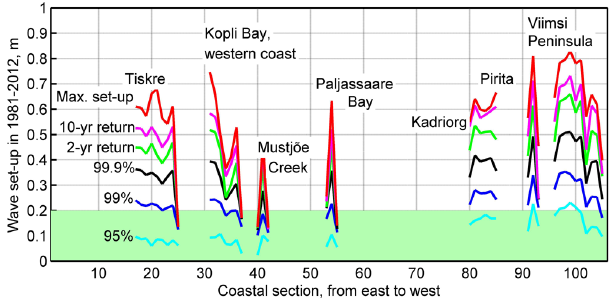
Fig. 11. Maximum wave set-up values, higher quantiles of set-up heights and 2yr and 10yr return values of set-up heights for the coastal sections where high set-up is an